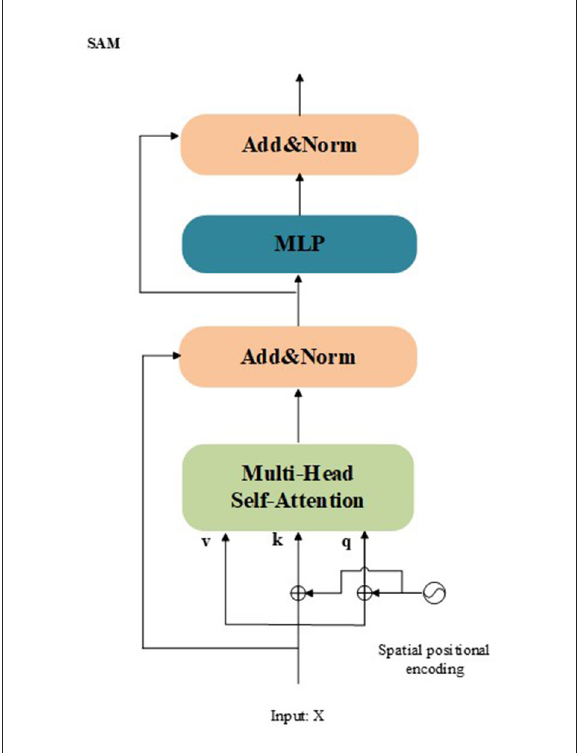
FIGURE3 Architecture of the proposed